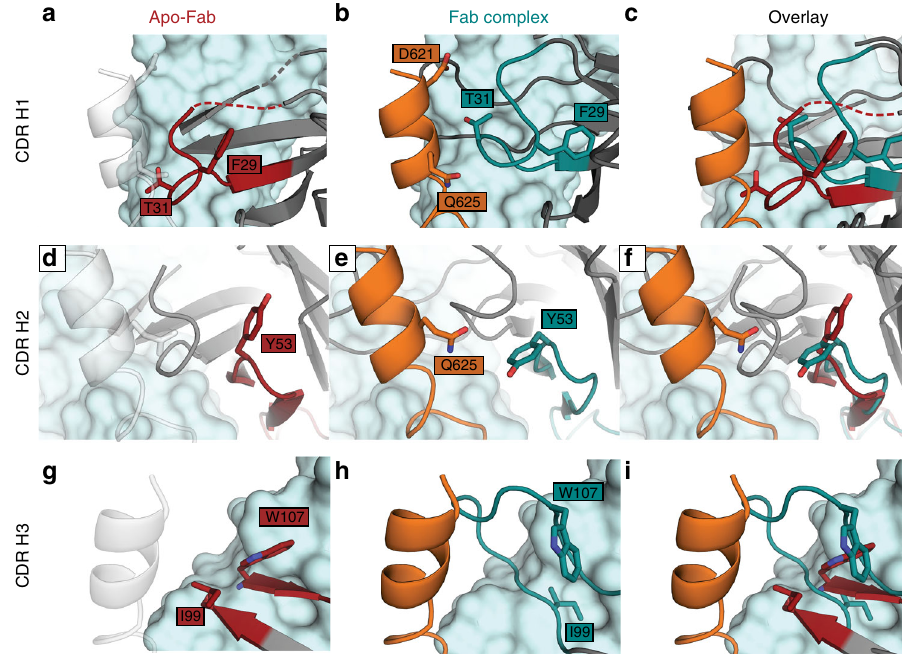
Fig. 2 Heavy chain CDR movements upon binding the peptide. The heavy chain CDRs of BDBV223 undergo induced fi t rearrangement upon binding the peptide. a – c CDR H1 maintains a similar structure overall, but shifts towards the N-terminus of the peptide. a Unbound CDR H1 is illustrated in red. b Bound CDR H1 is illustrated in cyan. c Superimposition indicates the repositioning of CDR H1 upon binding of the GP2 peptide. d – f CDR H2 does not have a signi fi cant main chain shift, but shows a signi fi cant rotameric change in Y33 towards GP2, where the helical character breaks down. g – i CDR H3 demonstrates the largest induced fi t rearrangement, with signi fi cant shifts in the positions of anchor point residues I99 and W107 and ordering of contact residues 100 – 106 only upon GP binding. The peptide is colored orange in the complex and is transparent in the Apo-Fab structure. Changes in the light chain are minimal. Color Scheme: